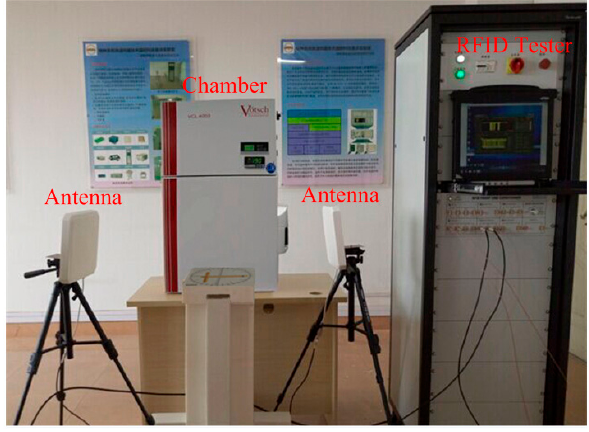
Figure 14. Wireless measurement environment.